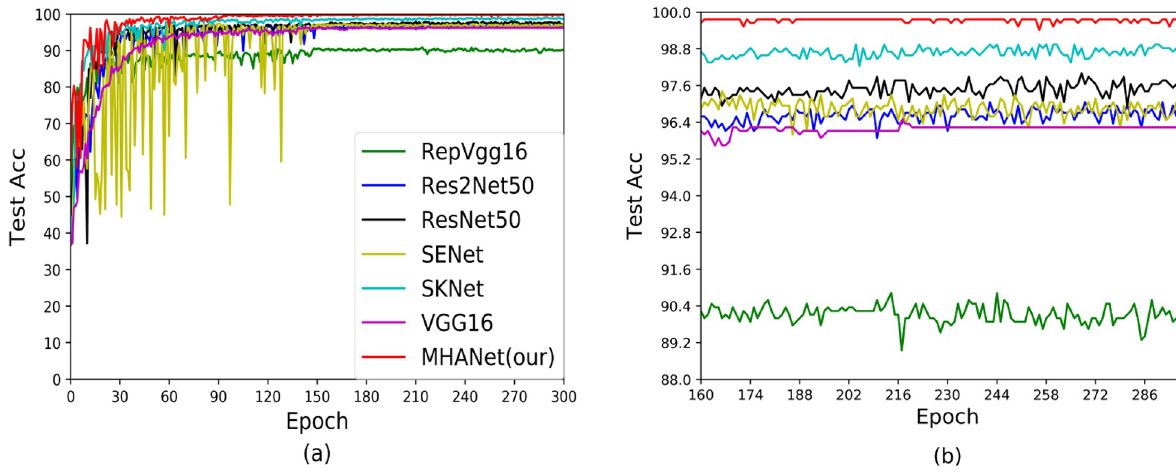
Fig 6. Test accuracy curves of